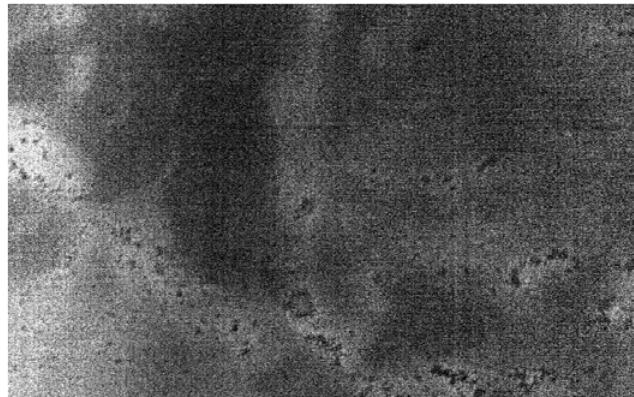
Figure 2. First derivative between spectral bands 3 and 4 of the Red Sea dataset.